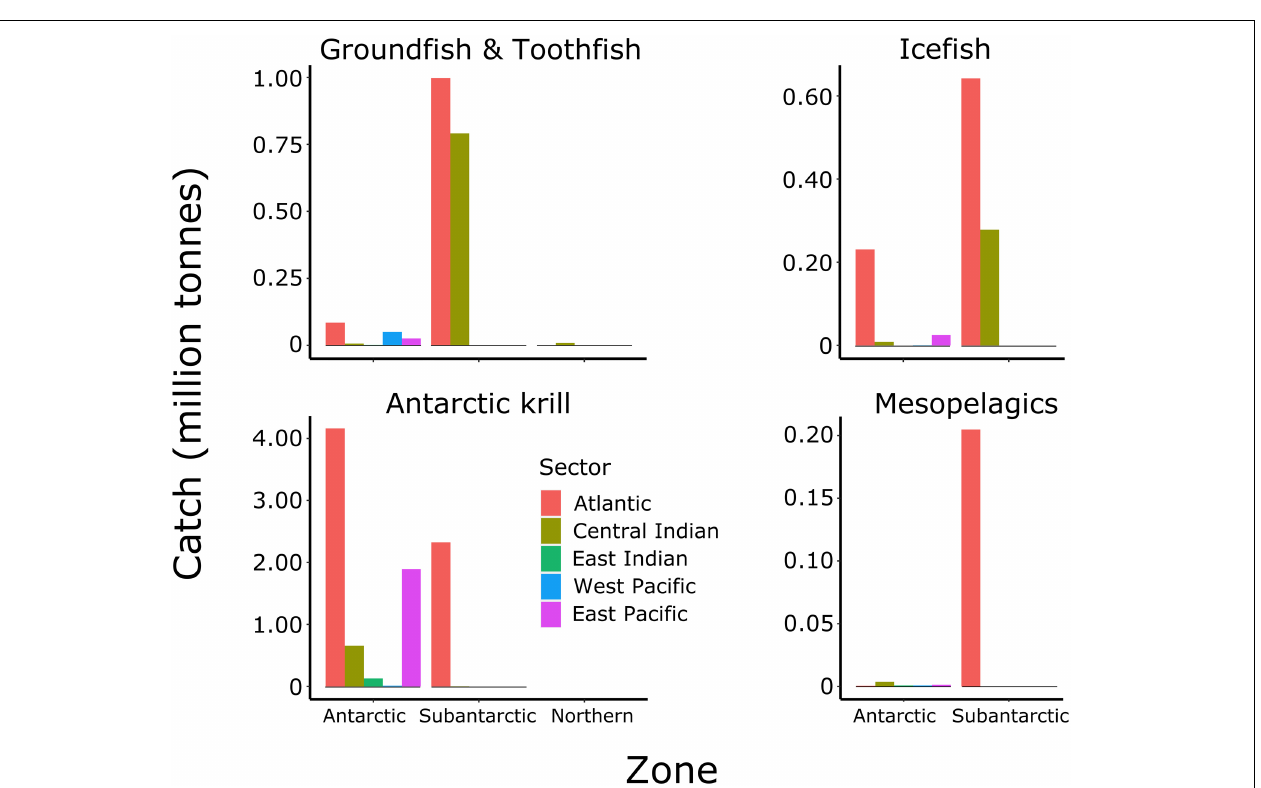
FIGURE 8 | Total accumulated catches (tonnes) of four major groups of target species in each sector (legend) from each zone for MEASO areas as shown in Figure 2 . Groundfish are primarily Notothenia rossii , Gobionotothen gibberifrons , Patagonotothen guntheri , and Lepidonotothen squamifrons . Toothfish are Dissotichus eleginoides and D. mawsoni . Icefish are primarily Champsocephalus gunnari in the Subantarctic and Chaenodraco wilsoni in the Antarctic. Antarctic krill are Euphausia superba . Mesopelagics consist of myctophids (primarily Electrona carlsbergi ) and silverfish ( Pleuragramma antarctica ). Data from the CCAMLR Statistical Bulletin